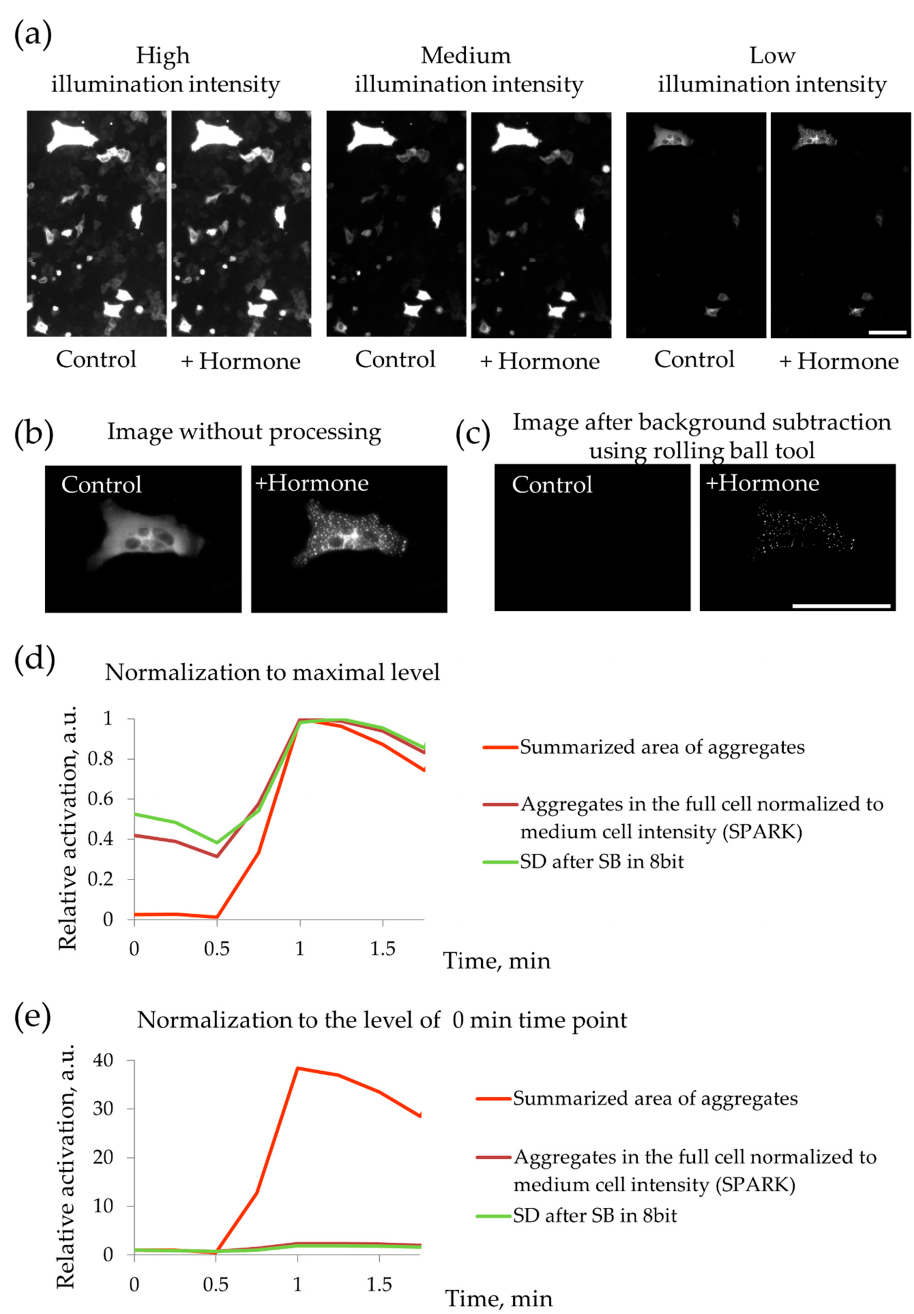
Figure 5. Testing the method of registration of PKA activity using PKA-Spark fluorescent probe. ( a ) PKA-Spark was expressed in HeLa-Kyoto cells with different expression levels and the cells were stimulated with serotonin (10 -5 M). Fluorescence of the same field of view was registered with different illumination intensity (marked above the pictures). It is seen that only the most bright cells expressing the probe with relatively high level, demonstrated hormone-dependent response. Scale bar 100 µ m. ( b , c ). Processing of fluorescent images of responding cells. ( b ) Responding cell before and after hormone adding without image processing. ( c ) Fluorescent figures after background subtraction using rolling-ball tool. Scale bar 100 µ m. ( d , e ) Test of di ff erent strategies of quantification PKA-Spark fluorescent droplets formation. ( d ) The results of quantitative analysis were normalized to the maximum measured level. ( e ) The results of quantitative analysis were normalized to the zero time